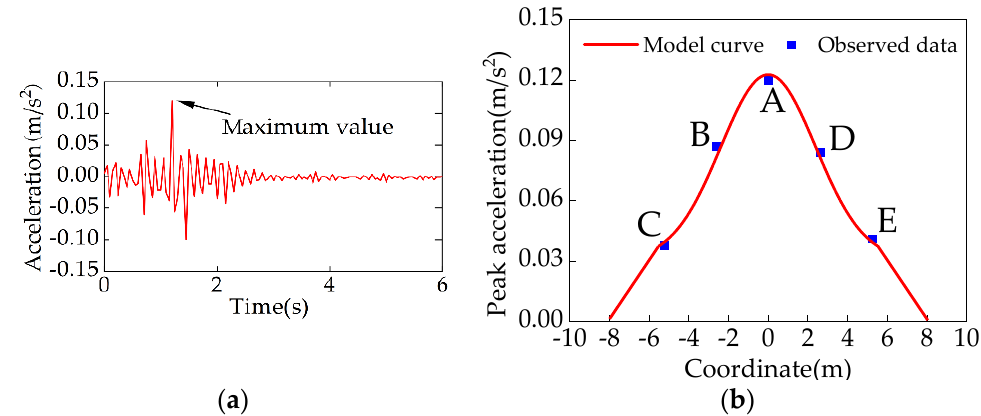
( b ) Figure 18. Dynamic response test: ( a ) test site; ( b ) layout position of acceleration sensors. According to the actual measurement size, the finite element model of the 15.6 m × 17.5 m span open-web sandwich plate was established at a ratio of 1:1. The translational and rotational degrees of freedom of the grid intersections around the floor were con- strained. We set the point of excitation at the geometric center of the floor (point A) for the transient analysis, and peak acceleration responses at different locations on the floor are recorded. The nonlinear curve was fitted to the finite element calculation results ac- cording to Equation (6) to obtain the model curve. A comparison between the model curve and the peak acceleration response of the measured points (A~E) on the project site is